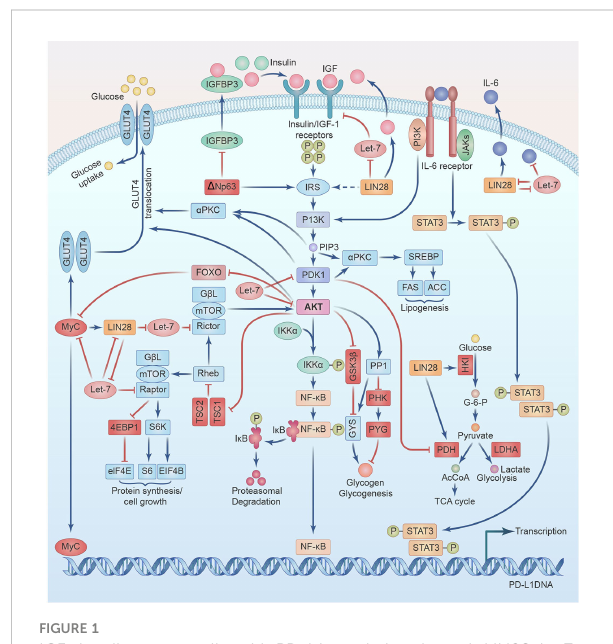
FIGURE 1 IGF signaling cross-talks with PD-L1 regulation through LIN28-Let7 axis and IL-6 ampli fi cation loop in Head and Neck Squamous Cell